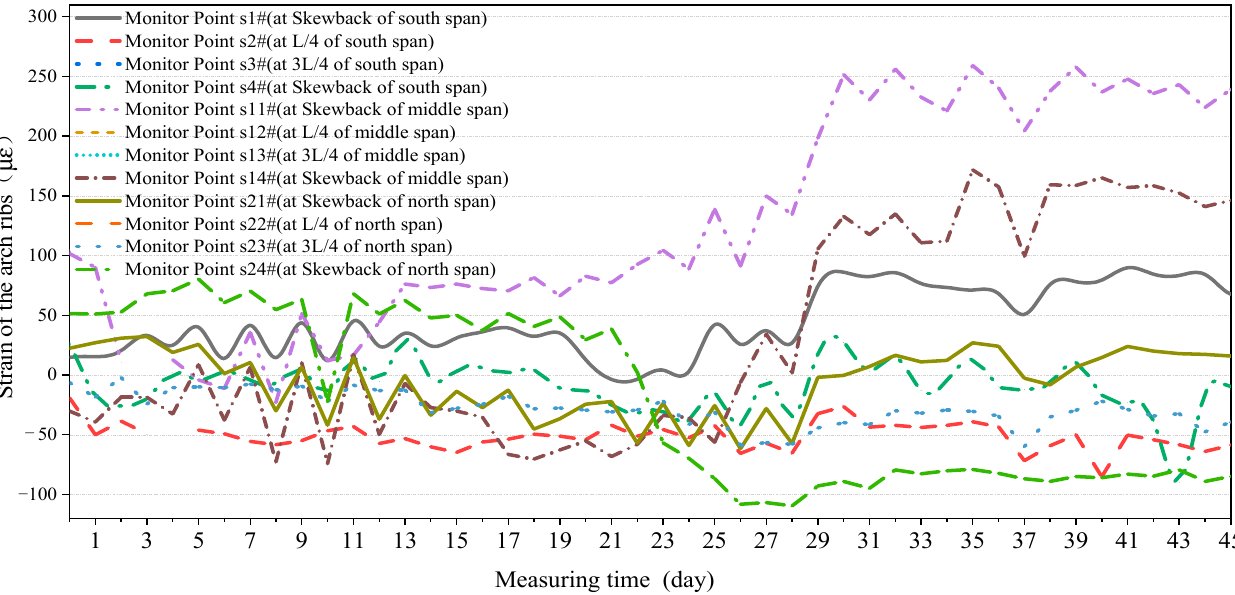
Measuring time (day) Figure 12. Monitoring results of the strain on arch Figure 12. Monitoring results of the strain on arch ribs.